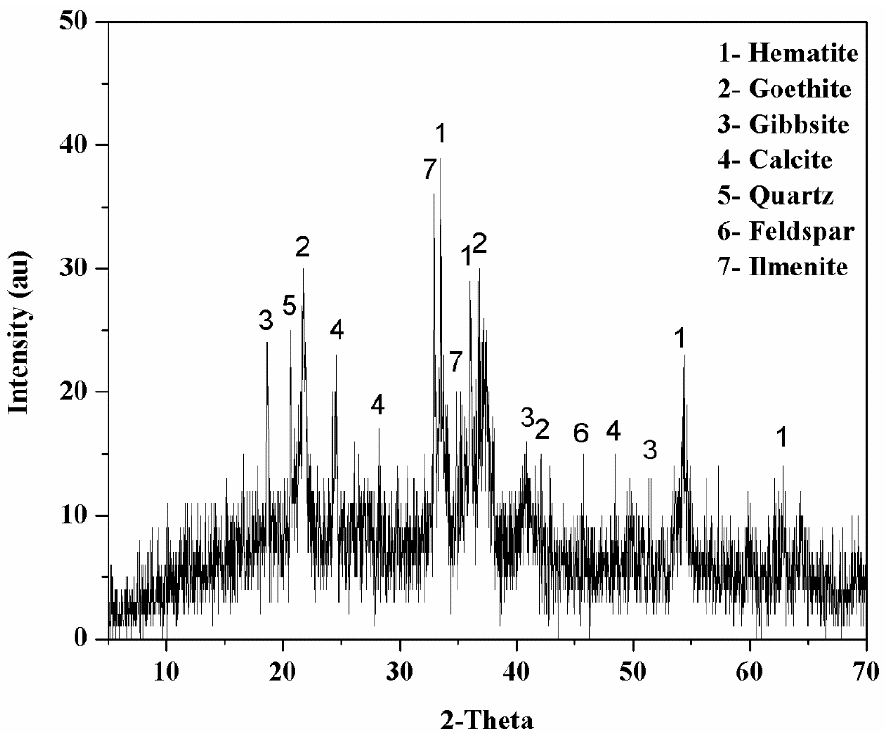
Figure 1. XRD pattern of red mud.